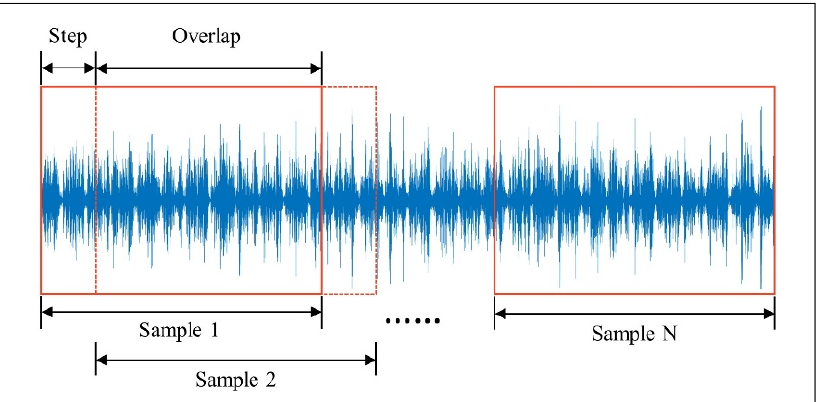
Figure 2. Process of data